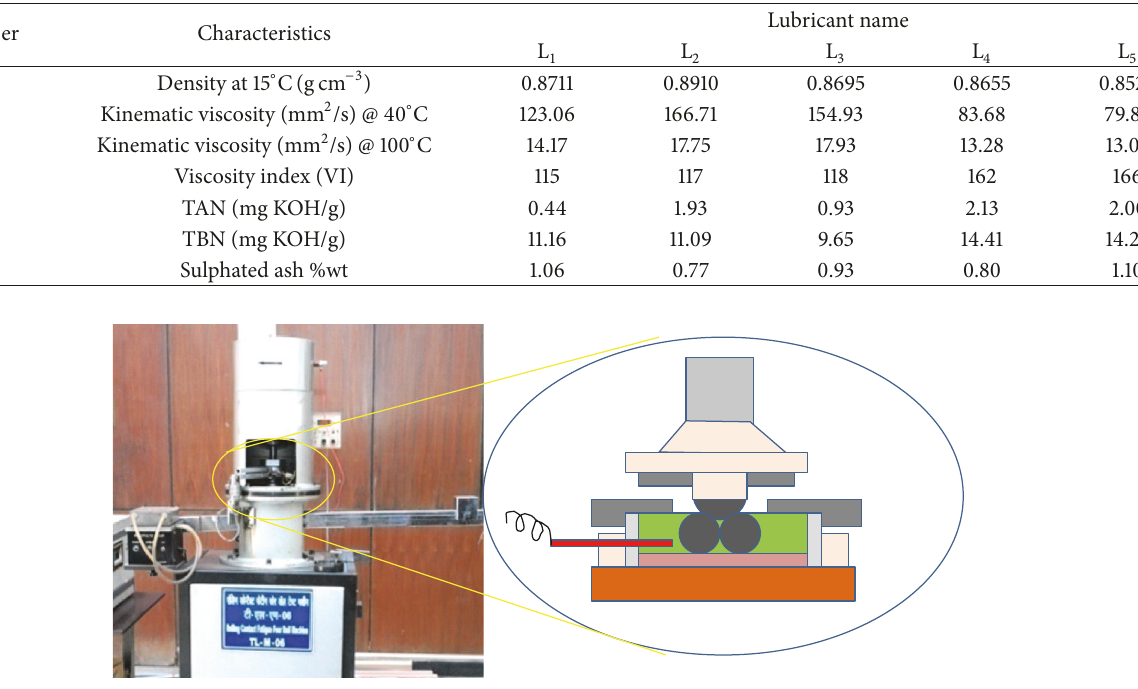
Table 3: Physicochemical properties of the lubricants.